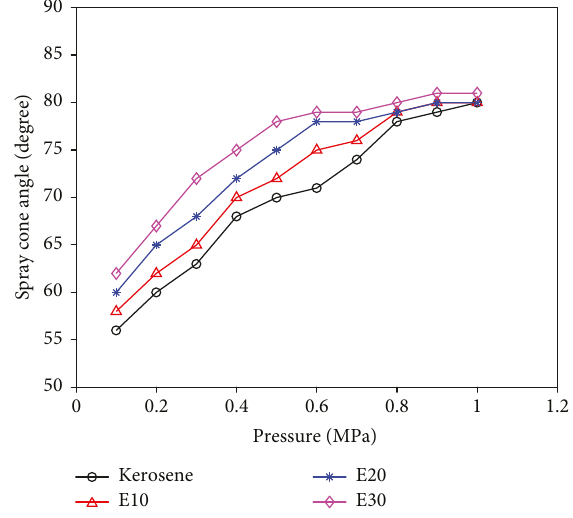
Figure 4: Variation of spray cone angles of kerosene and the blends with the injection